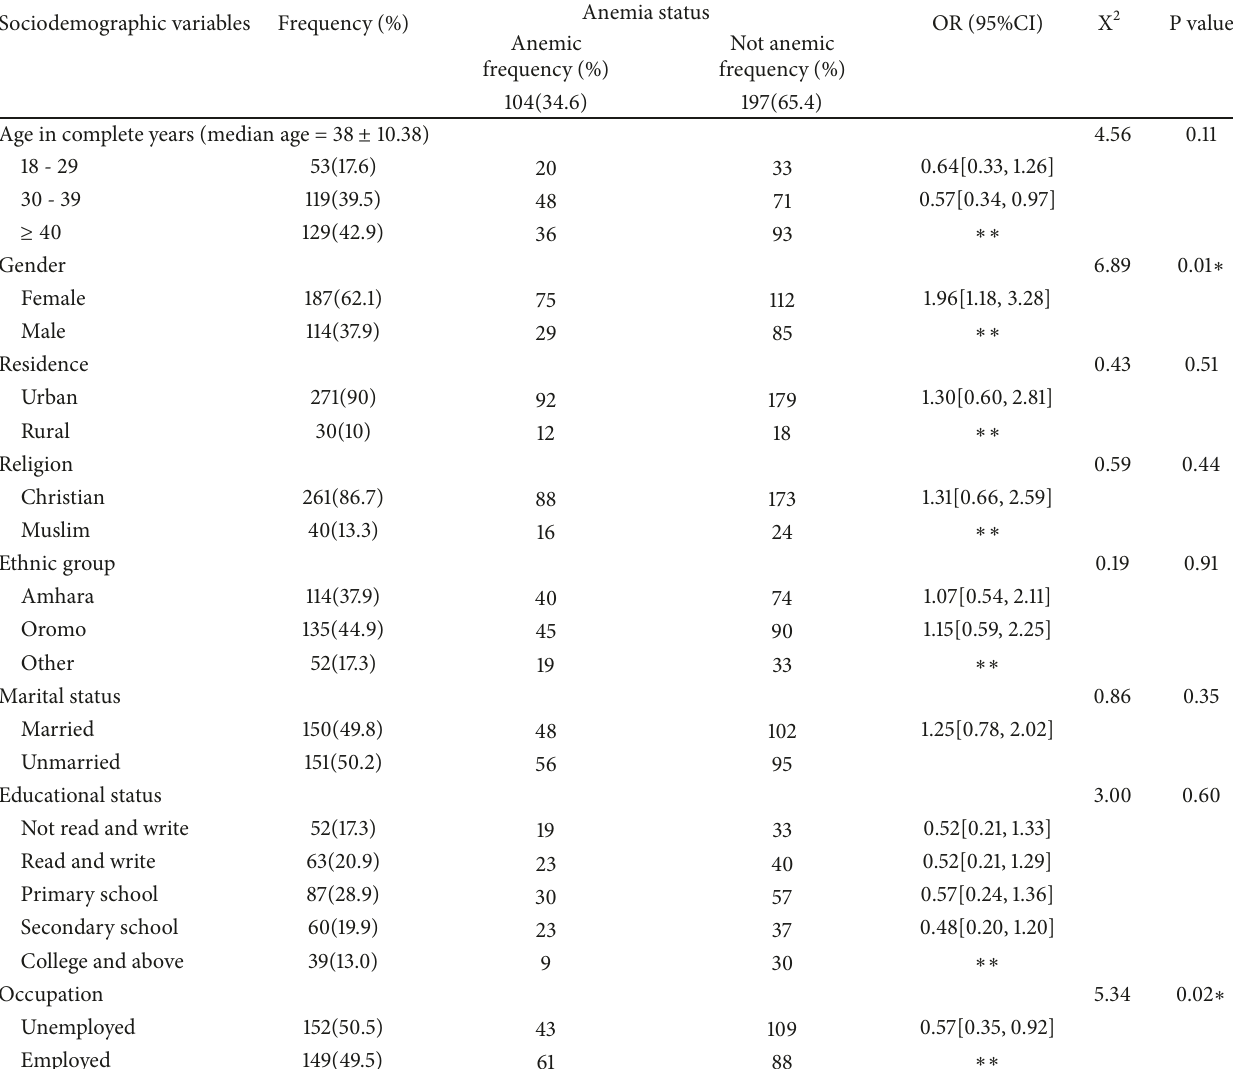
Table 2: Sociodemographic characteristics and their association with anemia under unadjusted logistic regression analysis (n = 301). Sociodemographic